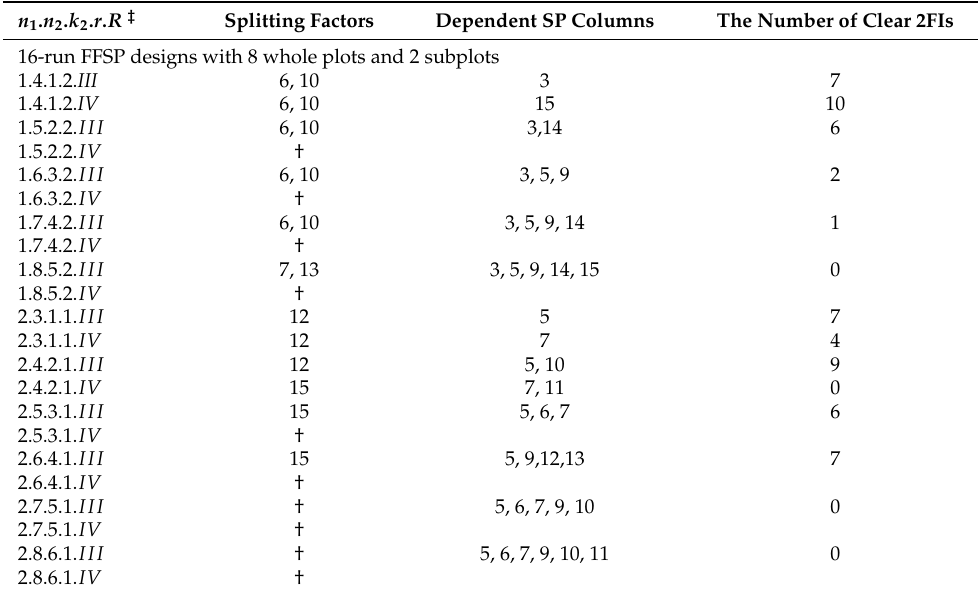
Table 2. Example 16-run FFSP designs with splitting factors which have the most clear 2FIs. n 1 . n 2 . k 2 . r . R ‡ Splitting Factors Dependent SP Columns The Number of Clear 2FIs 16-run FFSP designs with 8 whole plots and 2 subplots 1.4.1.2. III 6,